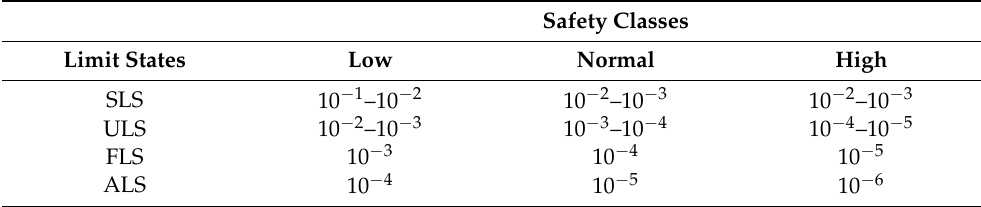
Figure 2. The target reliability indices corresponding to several reference rules. Table 1. Failure probability